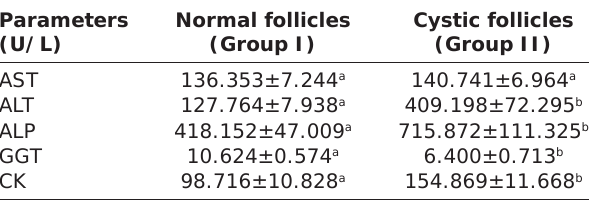
Table-2: Mean values (±SE) of different enzymatic activities of follicular fluid of